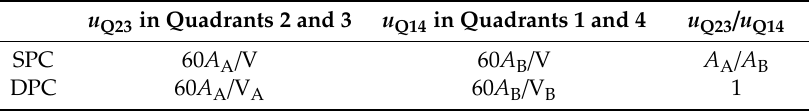
Table 3. Feedforward gains of four-quadrant operation.